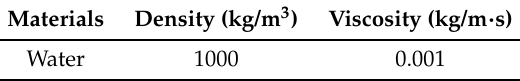
Table 3. Physical properties of fluid.